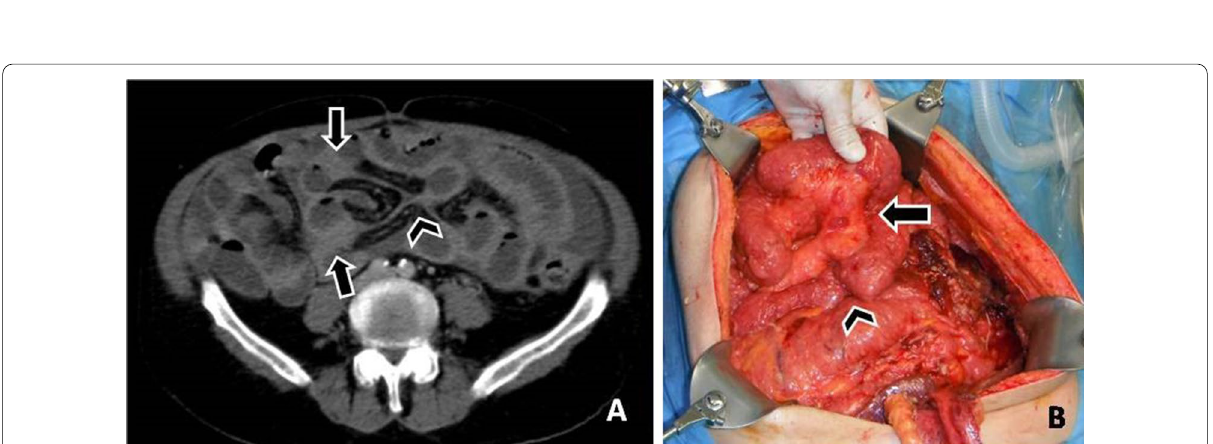
Fig. 10 a CT enteroclysis image demonstrates extensive wall thickening of the small bowel (arrows)—“layered type” of SB involvement and thickening of the mesenteric surface (arrowhead). b . Corresponding surgical imaging